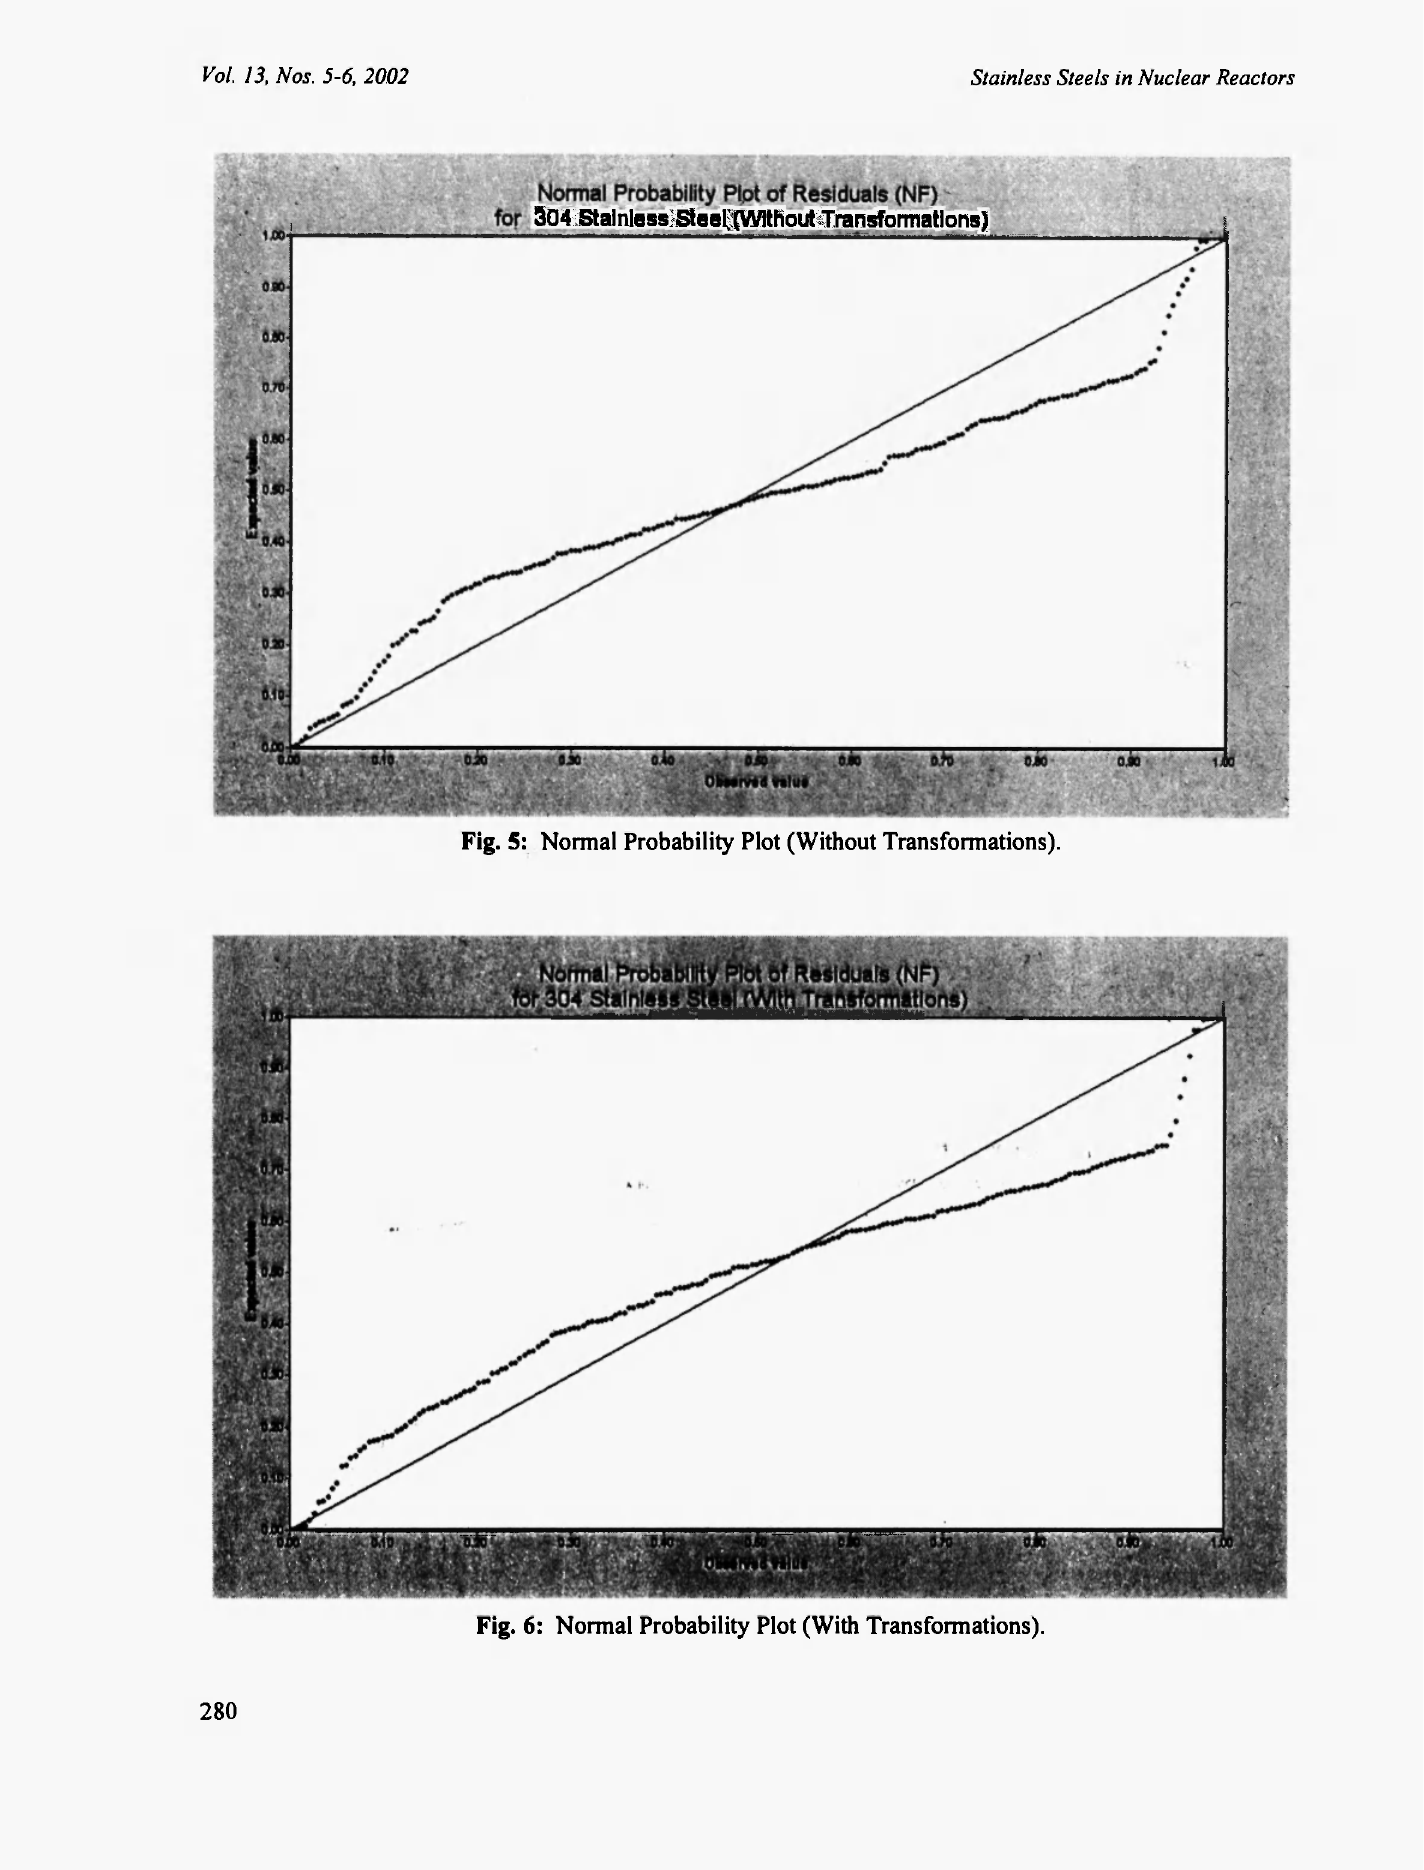
Fig. 6: Normal Probability Plot (With